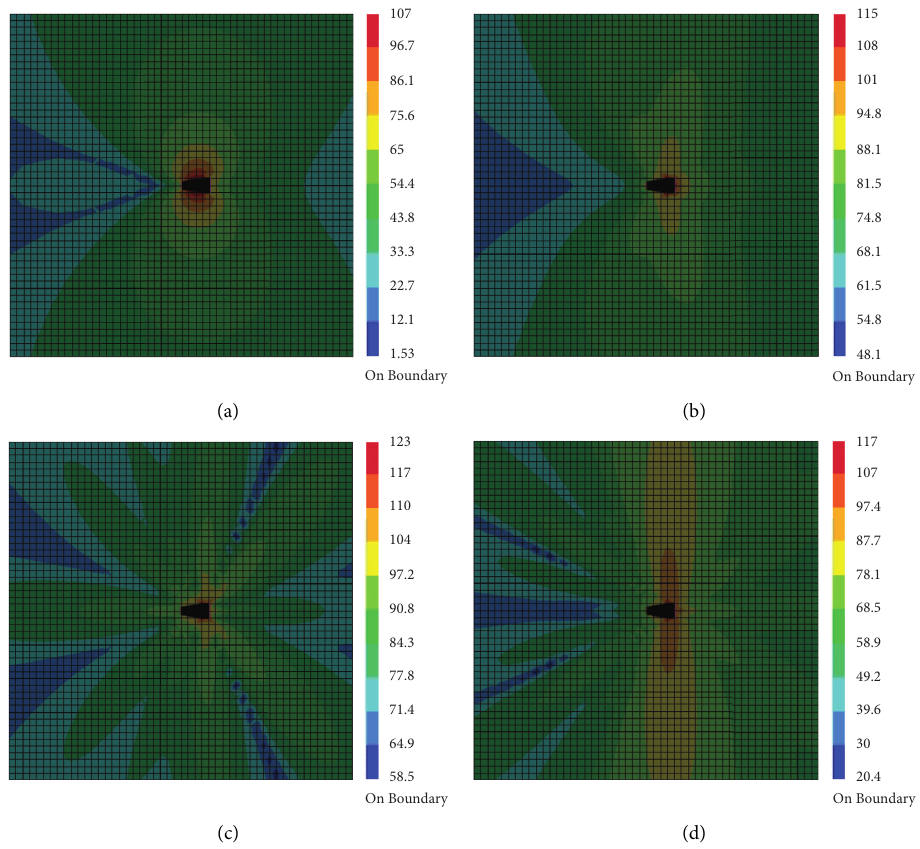
Figure 5: Acoustic radiation field at different frequencies in the xoy plane. (a) 50Hz. (b) 1000Hz. (c) 2000Hz. (d)